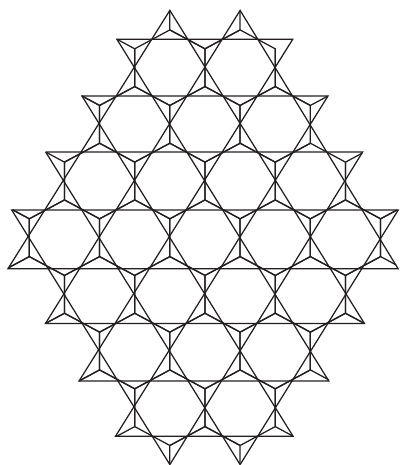
Figure 9: For n � 3, silicate network SL